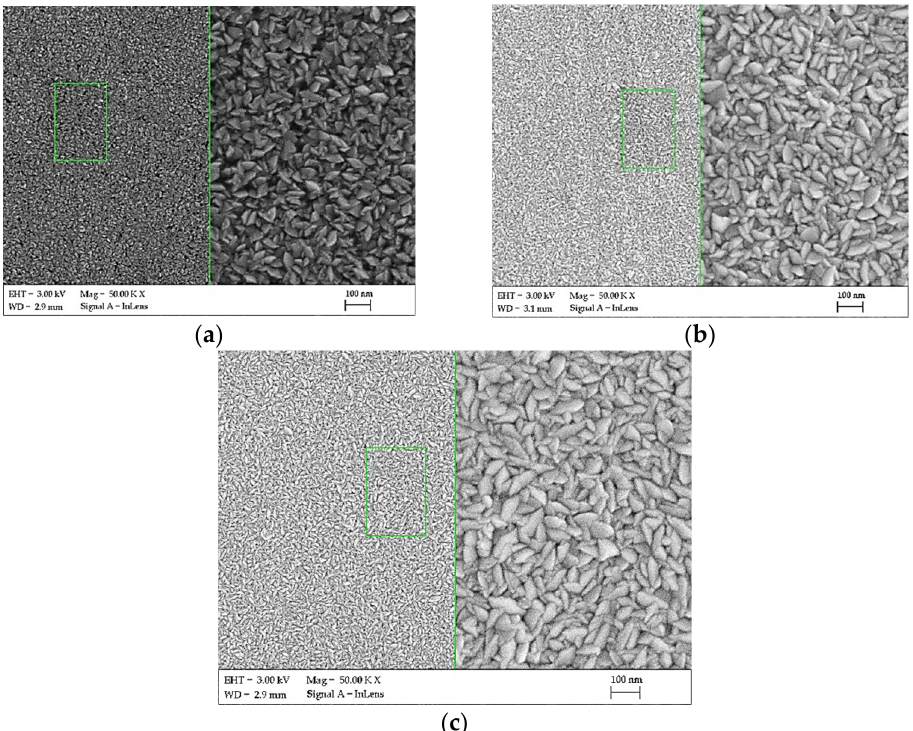
Figure 5. SEM breakthrough images of the ZnO thin film deposited after ( a ) 500 cycles, ( b ) 1000 cycles, and ( c ) 1500 cycles.